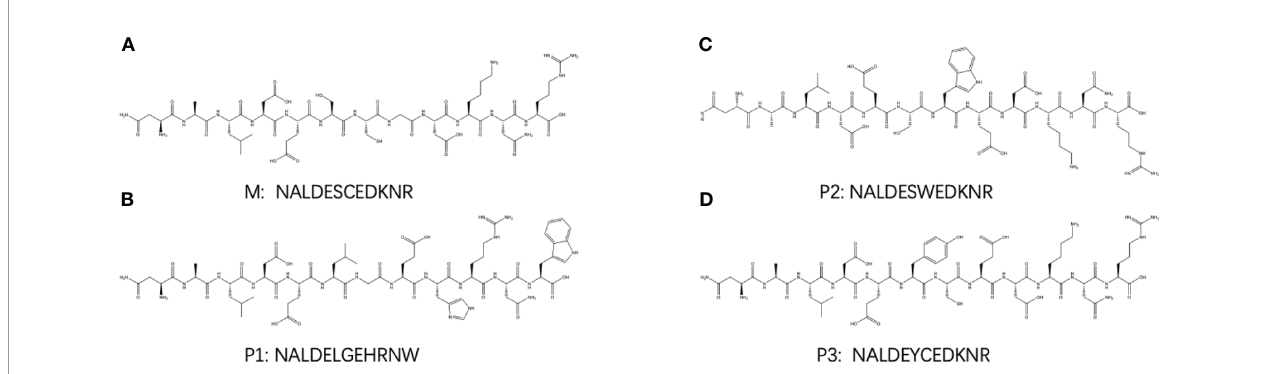
FIGURE 2 | The structure of HLA-E targeted binding peptides: (A) M, (B) P1, (C) P2, and (D) P3.